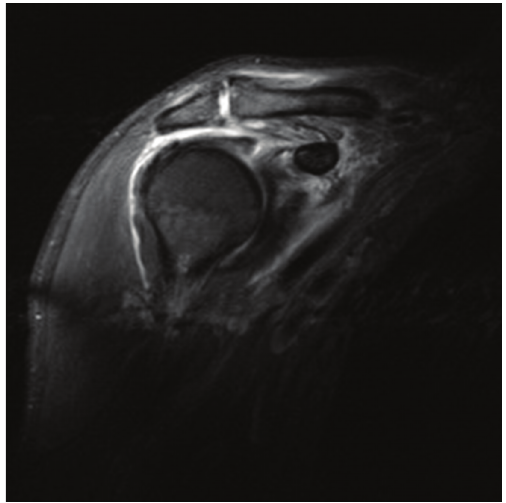
Figure 1: Coronal T2-weighted MRI scan showing collection in subacromial bursa.